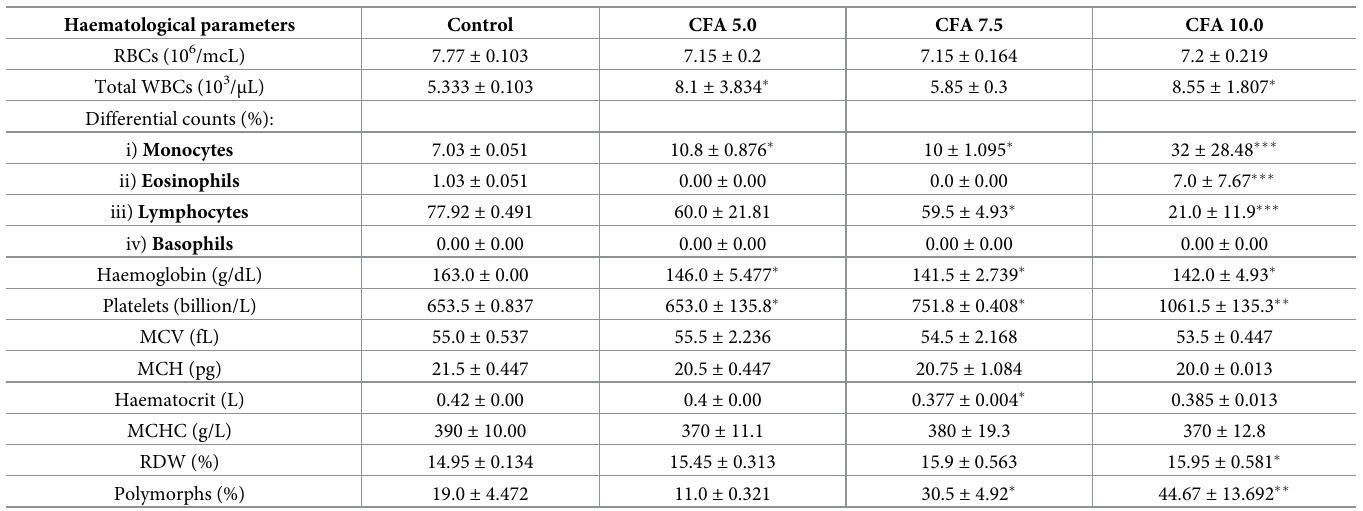
Table 1. Full blood count in the